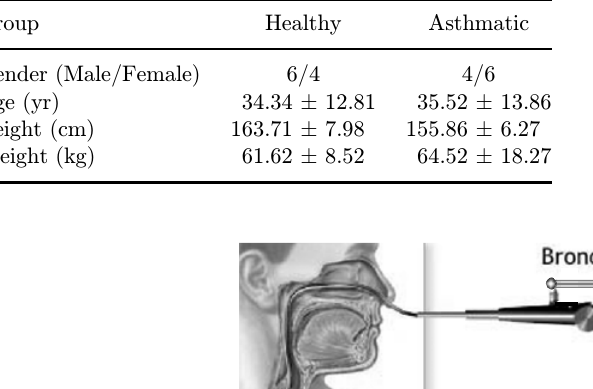
Table 1. Demographics of the volunteer test subjects. Group Healthy